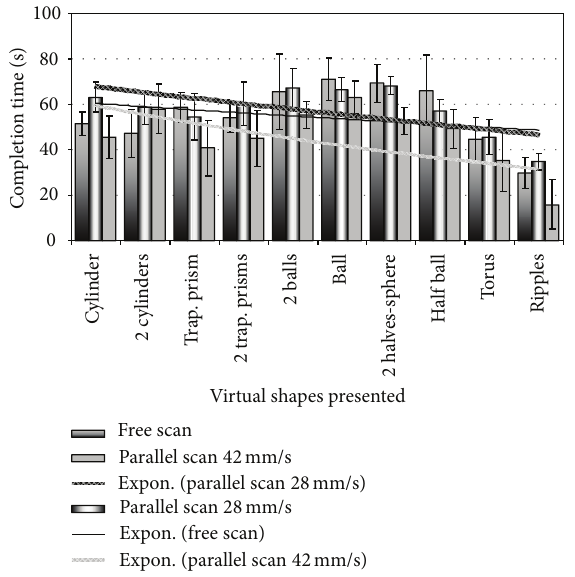
Figure 7: Mean completion time and trend lines of recognition and identification the virtual shapes for each of the three exploration conditions averaged over all participants.